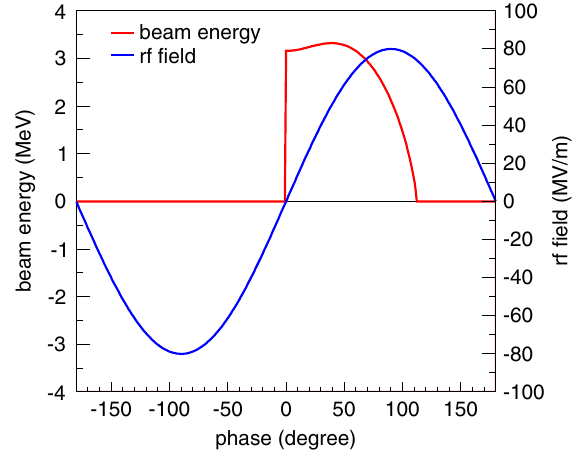
FIG. 3. Beam energy at the exit of the gun and longitudinal electric field strength at the cathode as a function of launch phase when an electron beam is emitted from the cathode. Since the field strength is a sine function, the field is maximal at 90 (cid:3) . However, the beam energy is maximal when a beam is launched at 37 (cid:3)